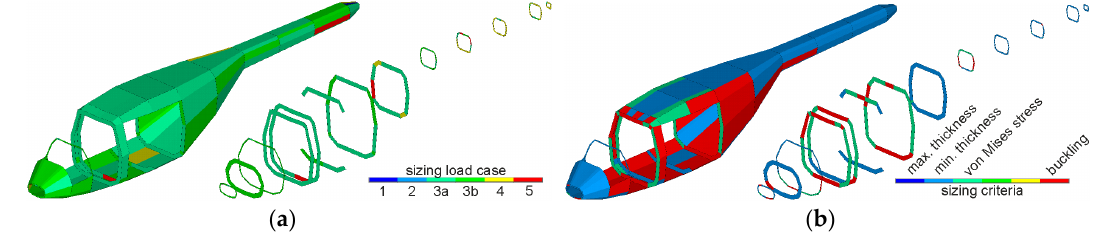
Figure 25. Model 05: ( a ) Critical load cases; ( b ) Sizing criteria.